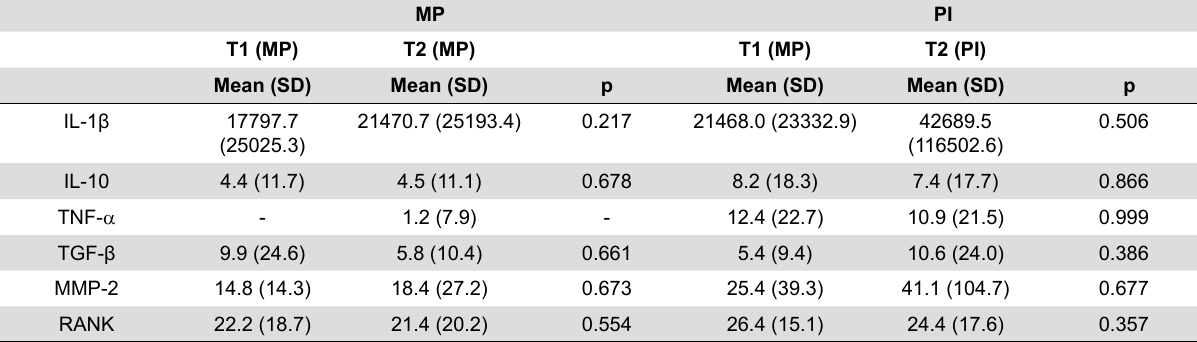
Table 3- Comparison of biomarker concentrations (pg/ml) based on clinical evolution from initial examination(T1) to final exam (T2)